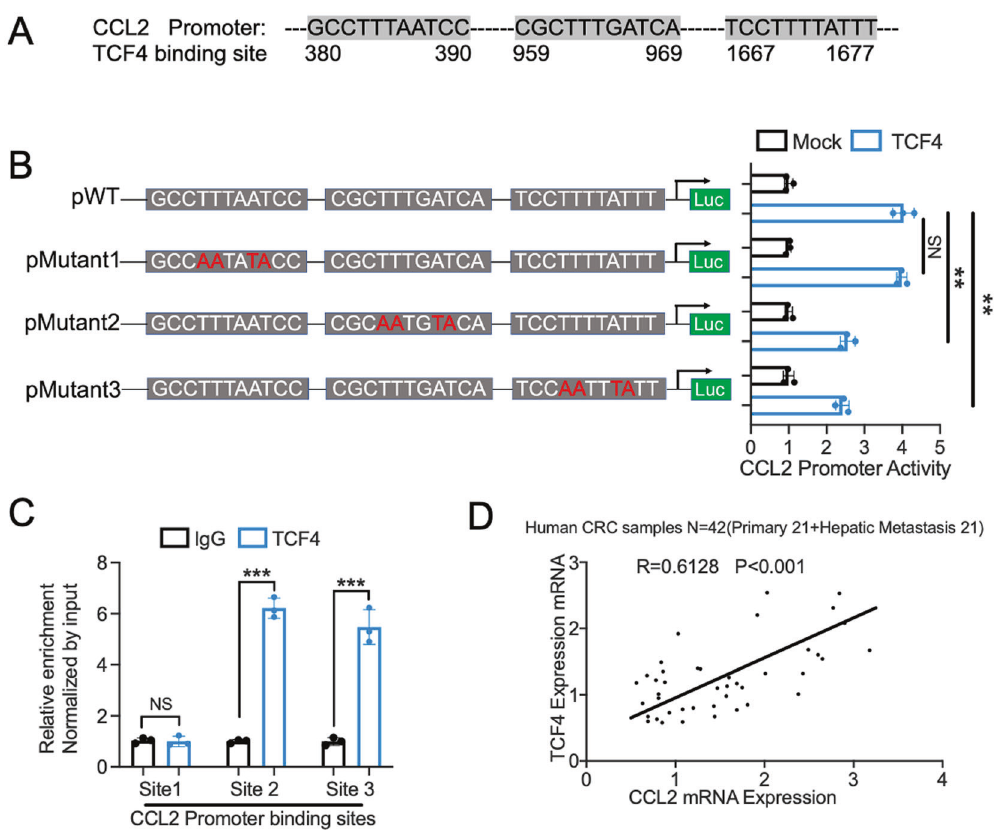
Fig. 8 TCF4 regulates CCL2 expression through binding to the promoter region. A The promoter sequence of CCL2 contains 3 putative TCF4 transcriptional factor binding sites. B Luciferase reporter assays for the activity of wild-type and mutant CCL2 promoters. n = 3 per group. C Quantitative analysis of ChIP experiments performed on DNA samples precipitated with antibodies against TCF4 and IgG using primers detecting putative TCF4 binding sites on CCL2 promoter. n = 3 per group. D Pearson correlation coef fi cient and p -value between TCF4 and CCL2 mRNA expression in colorectal cancer samples. (Total n = 42; Primary site, n = 21; hepatic metastasis, n = 21). Data are means ± SEM. * P < 0.05, ** P < 0.01, *** P < 0.005, **** P <